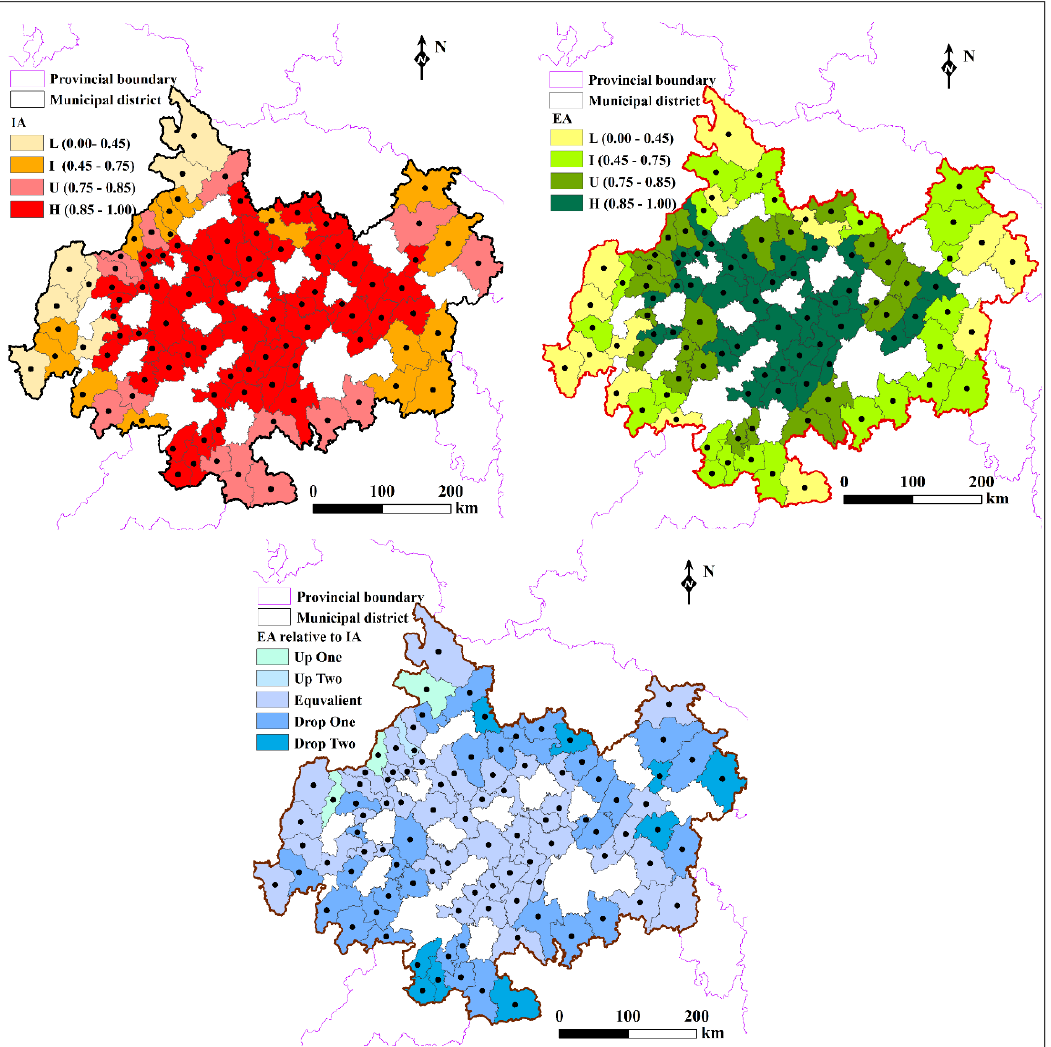
Figure 5. Distribution pattern of traffic accessibility in the Chengdu-Chongqing Economic Zone in 2020. Notes: IA: internal accessibility; EA: external accessibility. IA and EA were calculated according to Formulas (2) and (3) in the paper. L: low accessibility; I: intermediate accessibility; U: upper accessibility; H: higher accessibility. EA relative to IA represents the gap of accessibility level.